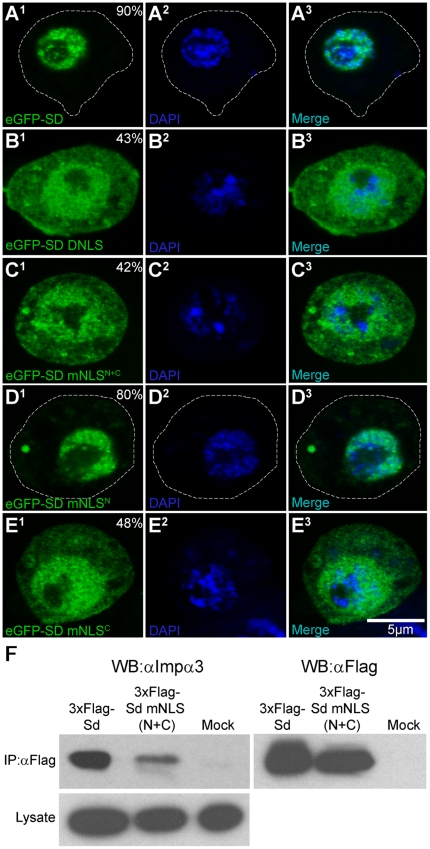
The intact NLS is necessary for both the proper nuclear translocation of Sd and Importin-α3 binding.(A–E) Localization of the indicated eGFP reporter tagged proteins in transiently transfected in S2 cells with DAPI stained nuclei and visualized via confocal microscopy. See the legend for Figs. 2A–G for details. (A) eGFP-SD. When Sd is expressed in S2 cells, reporter activity is predominantly nuclear. (B) eGFP-SD ΔNLS. Deleting amino acids 143–163 of Sd disrupts its localization and leads to diffuse reporter activity throughout both the nucleus and cytoplasm. (C) eGFP-SD mNLSN+C. Mutation of the six basic amino acids identified as being part of the classical consensus bipartite sequence (see Fig. 1) to N causes disruption of localization similar to that seen when the NLS is deleted. (D) eGFP-SD mNLSN. When the two N-terminal basic amino acids are mutated to N, a lesser disruption of the nuclear signal is observed (compare to A). (E) eGFP-SD mNLSC. Sd with the four C-terminal basic amino acids mutated to N drives diffuse localization of the eGFP reporter, similar to that seen for SD ΔNLS and SD mNLSN+C. (compare to panels B and C, respectively). (F) Co-IP of Sd and Imp-α3. Cells expressing 3xFLAG-Sd, 3xFLAG-Sd mNLSN+C as well as cells mock transfected with water alone were lysed, immunoprecipitated with αFLAG beads and analyzed via western blotting. Detection was with anti-FLAG or anti-Imp-α3. Detection with anti-FLAG ensures expression of the two tagged proteins is approximately equal. The lysate of all cells had a strong Imp-α3 signal. Imp-α3 co-immunoprecipitated strongly with 3xFLAG-Sd, while only weakly with 3xFLAG-Sd mNLSN+C. The mock transfected cells showed almost no Imp-α3 signal after immunoprecipitation, controlling for the specificity of the anti-FLAG beads.